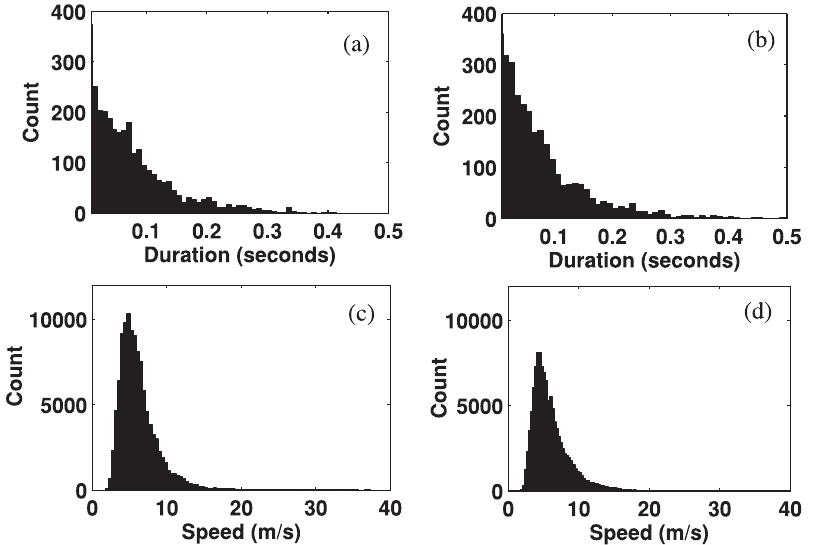
Figure 7. Histogram of the durations and speeds of alpha traveling waves during 500 ms time intervals before and after external stimulus onset, which were measured over all subjects. (a) Durations of prestimulus waves. (b) Durations of poststimulus waves. (c) Speeds of prestimulus waves. (d) Speeds of the poststimulus waves.